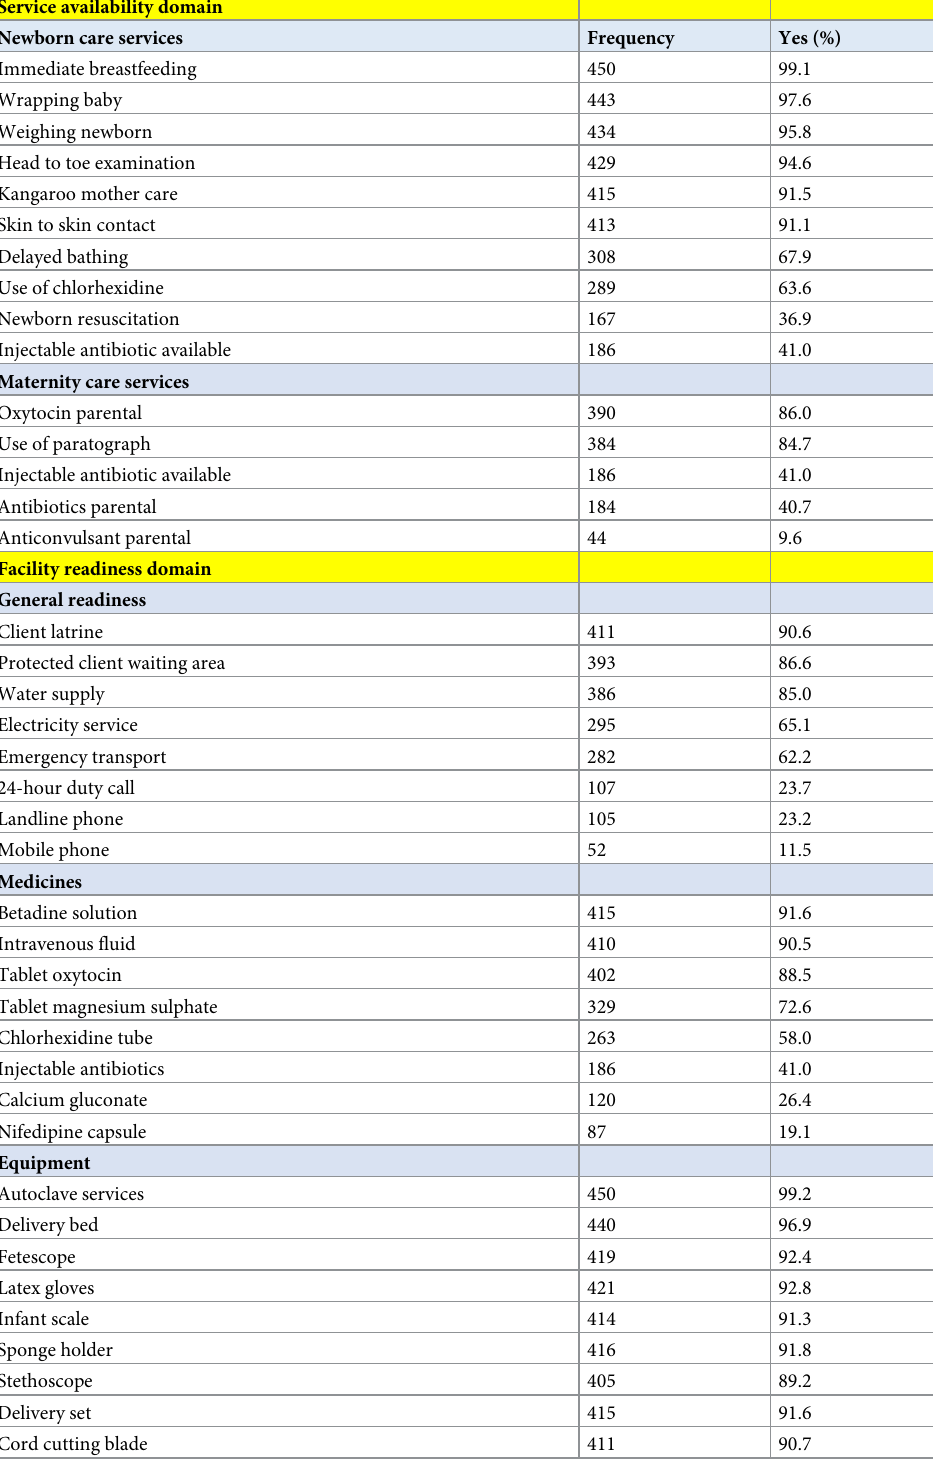
Table 3. Service availability and facility readiness assessment items of health facilities for perinatal services (N =